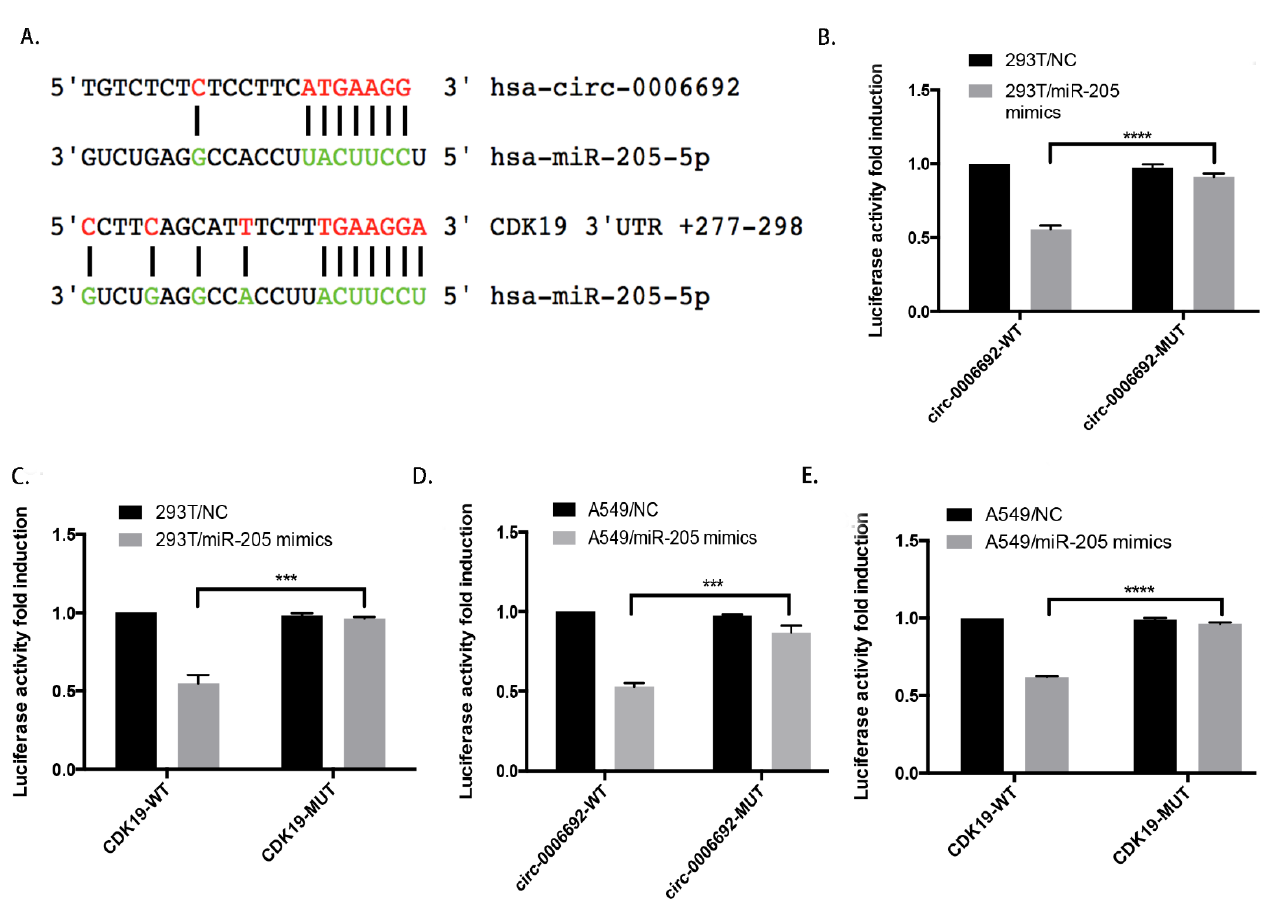
Figure 5. hsa_circ_0006692 played its roles via sponging hsa-miR-205-5p and regulating CDK19 . ( A ) Sequence alignment of hsa-mir-205-5p with putative binding sites in circ-0006692 and CDK19 wild-type and mutant regions; ( B – E ) Double Luciferase Report analysis showed that hsa-mir-205-5p mimics reduced the fluorescence intensity of HEK293T or A549 cells transfected with